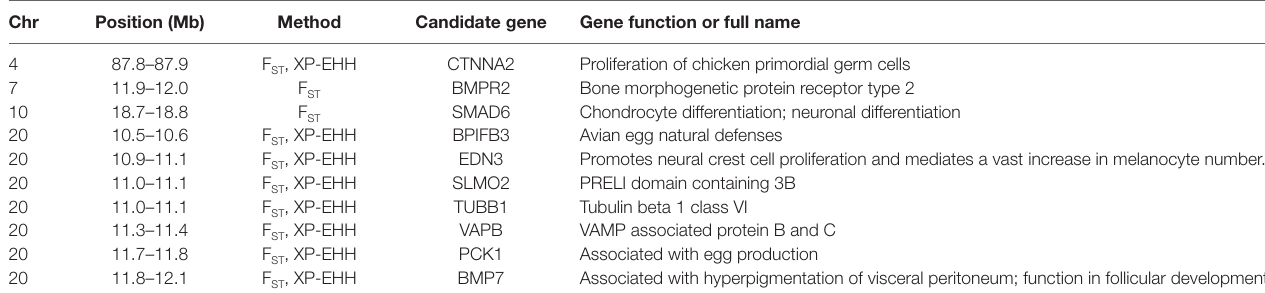
TABLE 3 | Summary of the most interesting candidate genes within extreme